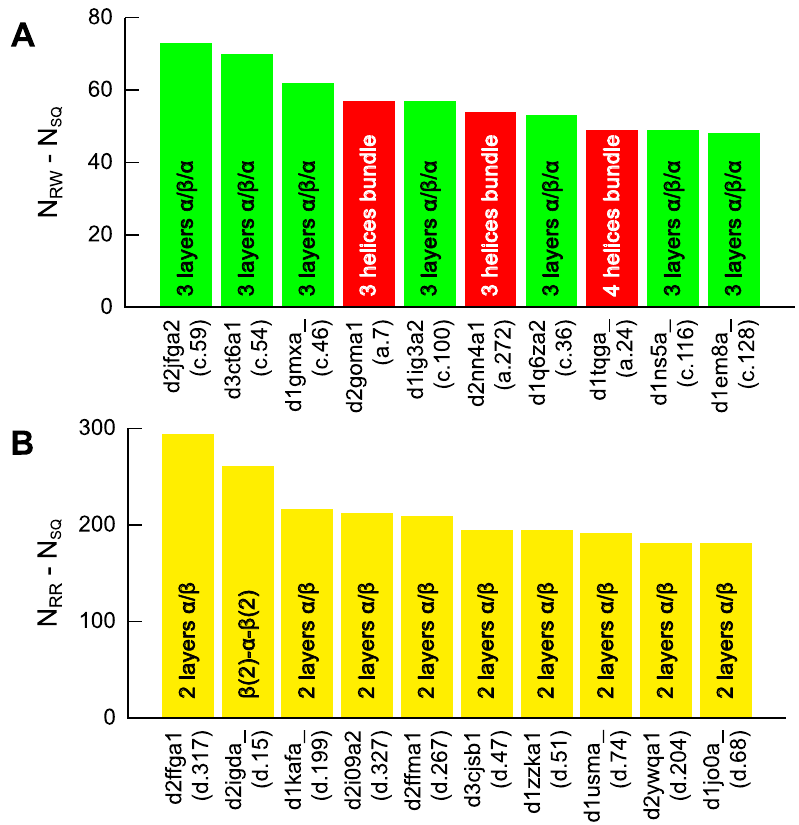
Figure 8. The top 10 SCOP folds having the largest numbers of structural neighbors identified by the RW (A) and RR (B) schemes. Each bar represents a fold representative, and it is colored by SCOP class as follows: all- a (red), all- b (blue), a / b (green), a + b (yellow), and others (black). The height of the bar represents N RW { N SQ or N RR { N SQ . The target proteins are ordered by their values of N RW { N SQ or N RR { N SQ . For each target, the SCOP ID and SCOP fold ID are given under the bar. Short descriptions of each fold are also given in the